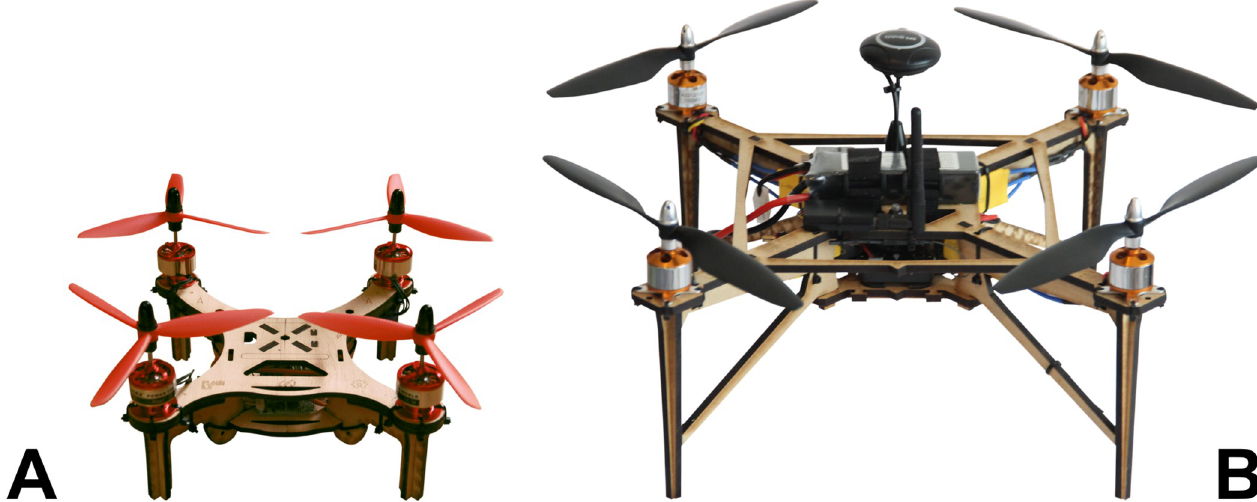
Fig 1. The Flone and OVLI drones. (A) original “Flone” design [28] upon which further versions of the open hardware drone were developed. (B) the “OVLI” drone that was developed as part of the Open Science Drone Toolkit.